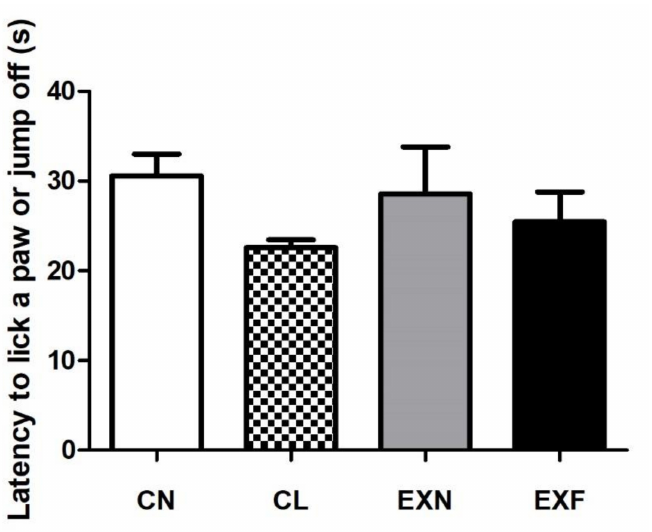
Figure 6. Latency to lick a paw or jump off (s) in mice with various body conditions. Abbreviations: (CN) control group of mice characterized by normal weight and physiological percentage of body fat deposits; (CL) control group of mice characterized by reduced weight and reduced body fat deposits; (EXN) experimental group of mice characterized by normal weight and moderately elevated body fat deposits; (EXF) experimental group of mice characterized by markedly elevated weight and body fat deposits. Data are shown as mean ± SEM.